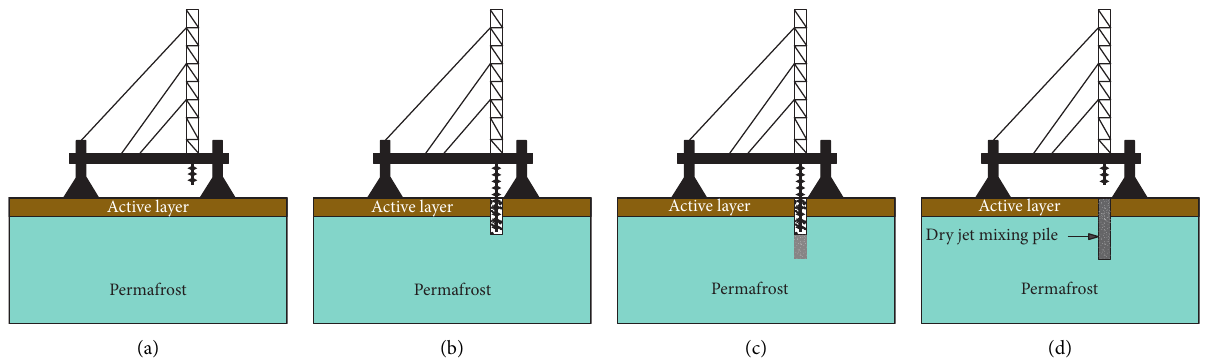
Figure 6: Installation of dry jet mixing pile. (a) Positioning. (b) Drilling. (c) Elevating. (d) Pile forming.